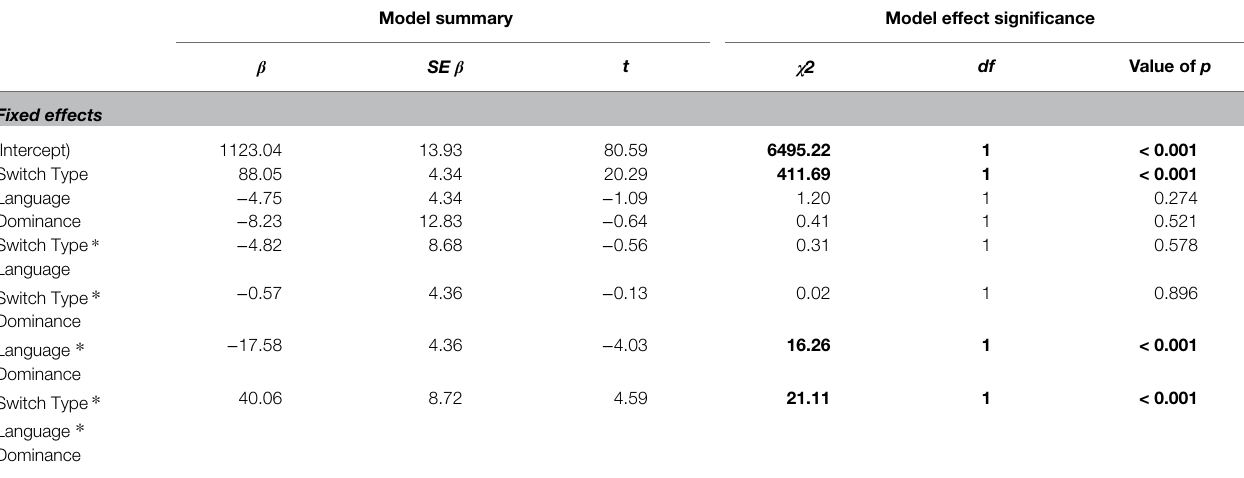
TABLE 4 | Results for linear mixed-effects model of response times in picture naming